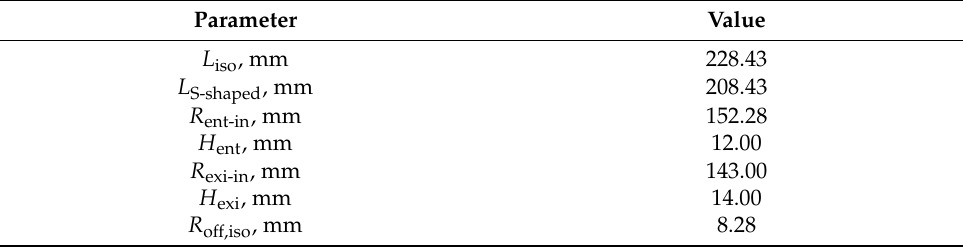
Figure 1. Sketch of the isolator model. Table 1. Geometric parameters of the isolator.